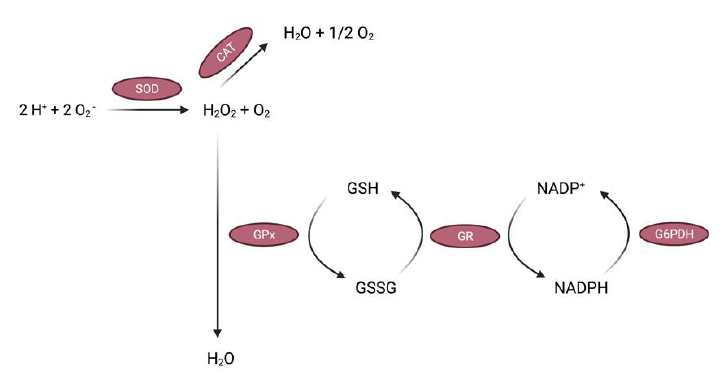
Figure 1. Schematic representation of enzymatic antioxidant mechanisms of action. Created with BioRender.com. SOD, superoxide dismutase; CAT, catalase; GPx, glutathione peroxidase; GR, glu- tathione reductase; G6PDH, glucose-6-phosphate dehydrogenase.